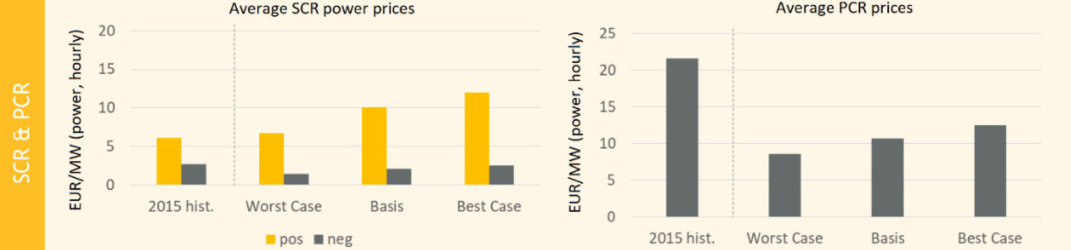
Figure 28. SCR and PCR prices in Germany in